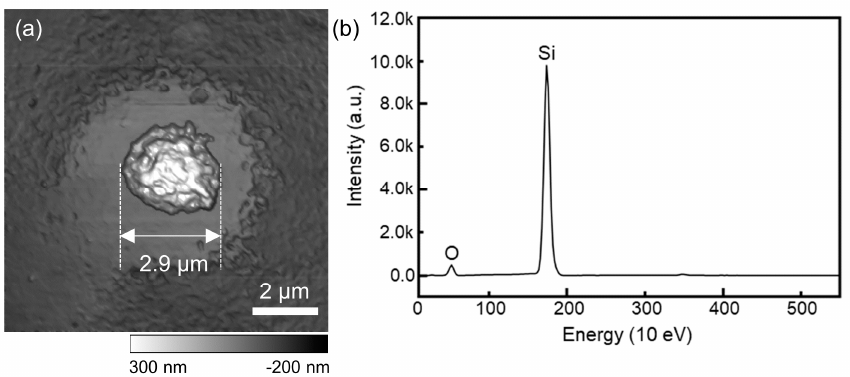
Figure 2. ( a ) High-repetition-rate femtosecond laser-induced convex structures, directly focused by an object lens (NA = 0.3, MPlanFLN, Olympus). ( b ) EDS of convex structures showing silicon was oxidized by a femtosecond laser.